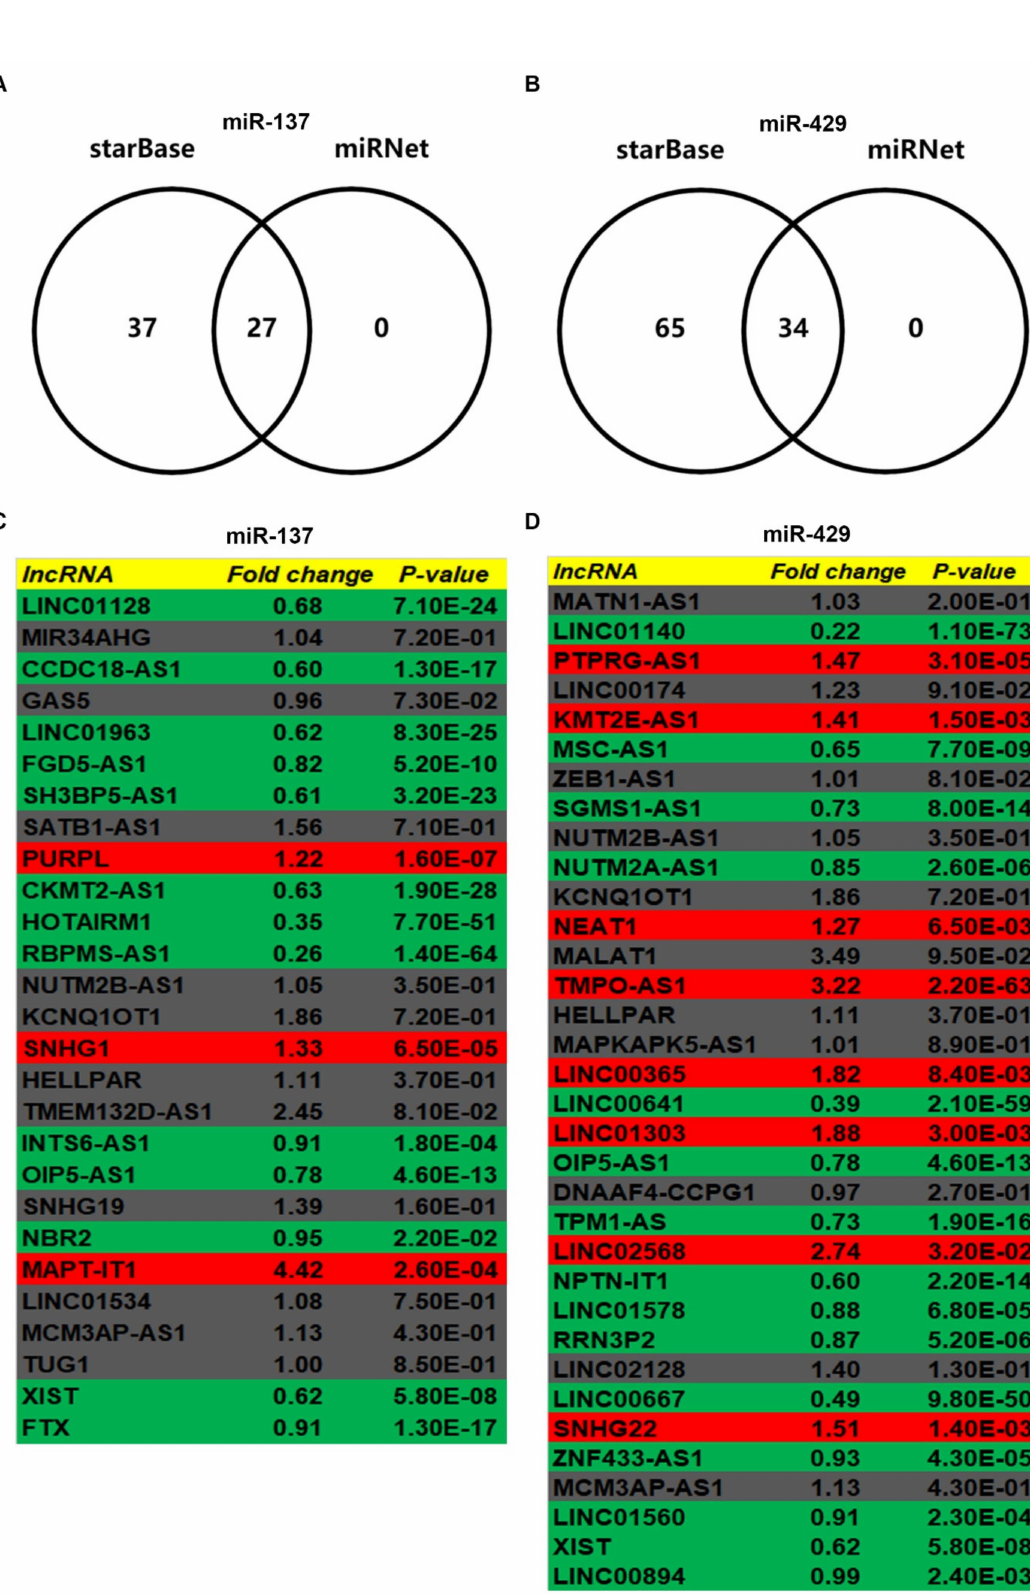
Figure 6. Prediction and expression analysis for upstream lncRNAs of miR-137 or miR-429 in breast cancer. ( A ) The intersection analysis of predicted lncRNAs from starBase and miRNet. ( B ) The intersection analysis of predicted lncRNAs from starBase and miRNet. ( C ) The expression landscape of predicted lncRNAs of miR-137 in breast cancer. ( D ) The expression landscape of predicted lncRNAs of miR-429 in breast cancer. “ p < 0.05” was considered as statistically